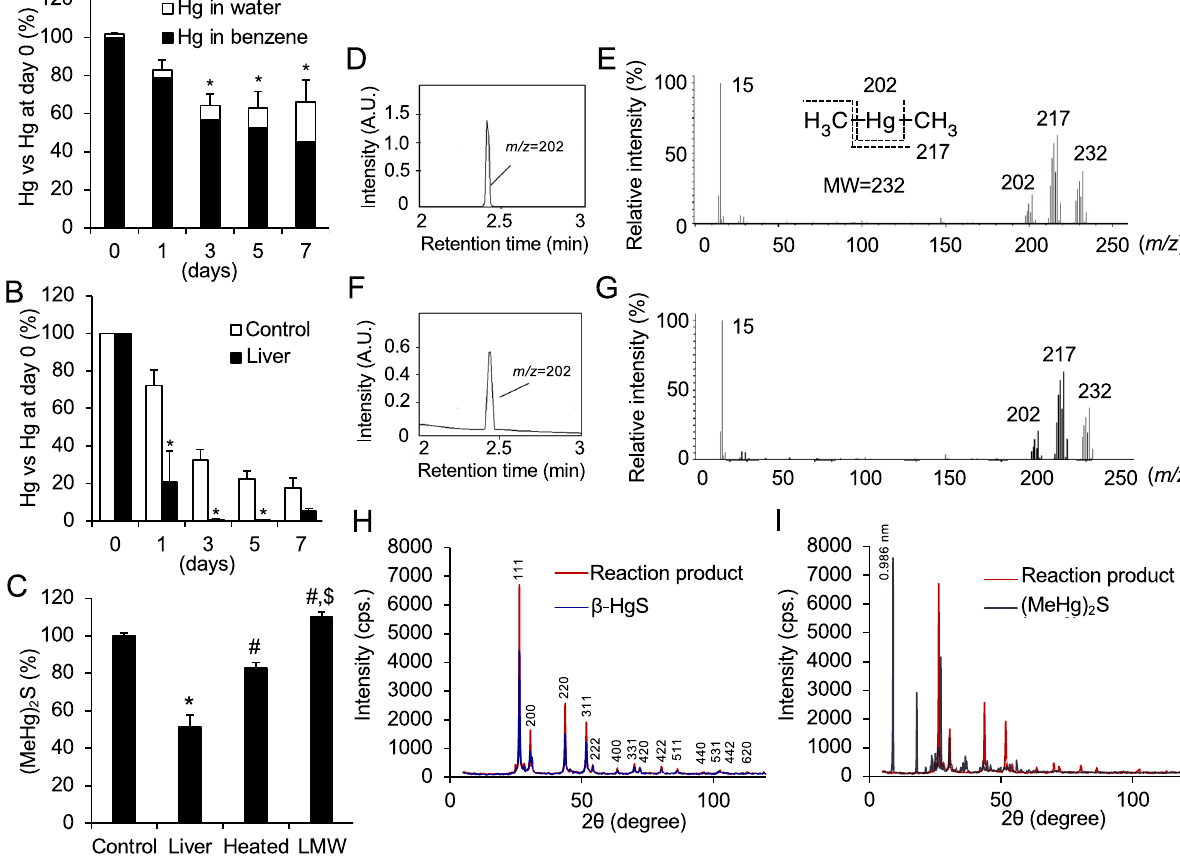
Figure 3. Detection of organic and inorganic mercury compounds during incubation with bismethylmercury sulfide. ( A ) (MeHg) 2 S was incubated for 0–7 days at 37 °C. After liquid–liquid extraction, the benzene layer and the water layer were separately analyzed by AAS. Each value is the mean ± SE of three determinations. * P < 0.01 vs. 0 day. ( B ) (MeHg) 2 S was incubated in mouse liver supernatant (liver) isolated by centrifugation at 9,000 g or in 50 mM KPi (pH 7.5) (control) for 0–7 days at 37 °C and detected by HPLC/AAS. Each value is the mean ± SE of three determinations. * P < 0.01 vs. 0 day. ( C ) Mouse liver 9000 g supernatant (2 mg/mL) was preincubated at 25 °C or 95 °C. (MeHg) 2 S (100 µM) was incubated in 50 mM KPi (pH 7.5) (control), supernatant (liver), heated supernatant (heated), or low-molecular-weight fraction of mouse liver 9000 g supernatant in 50 mM KPi (pH 7.5) (LMW) for 1 day at 37 °C. (MeHg) 2 S was analyzed by HPLC-AAS. Each value is the mean ± SE of three determinations. * P < 0.001 vs. control, # P < 0.01 vs. liver, $ P < 0.01 vs. heated. The head space of a sample tube containing (MeHg) 2 S was collected and analyzed by GC/MS. ( D ) Chromatogram of authentic DMeHg and ( E ) spectrum of the peak with a retention time of 2.5 min. ( F ) Chromatogram of the collected compounds and ( G ) spectrum of the peak with a retention time of 2.5 min. The residue after 7 days of incubation with (MeHg) 2 S was purified. ( H , I ) Decomposition product (reaction product), ( H ) authentic β-HgS, and ( I ) (MeHg) 2 S were analyzed by X-ray diffraction, and the patterns are